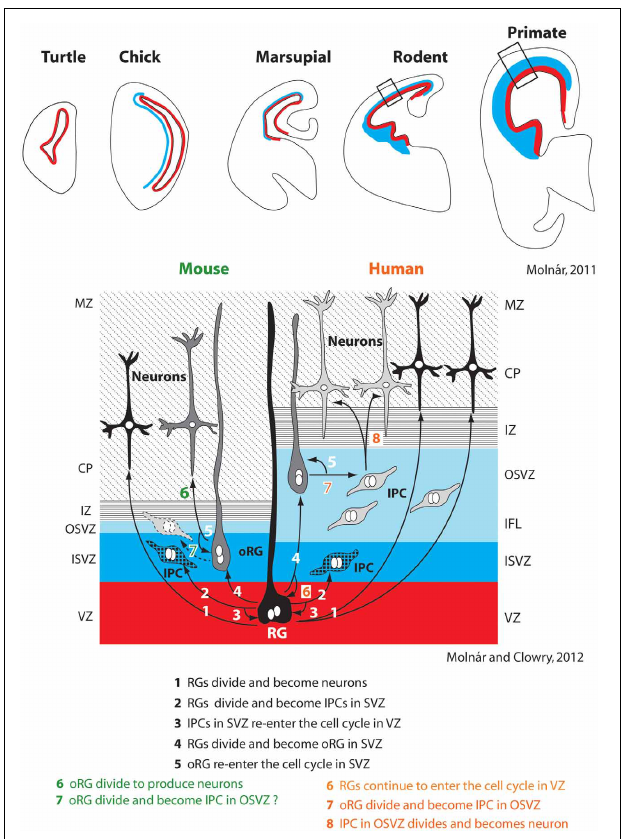
FIGURE 3 | Changes in the subventricular zone (SVZ; blue) in vertebrates (top row). Specific alterations in cell cycle kinetics, the overall thickness of the SVZ, the proportion of the SVZ corresponding to the inner and outer layers (ISVZ and OSVZ respectively), and the proportion of asymmetrical radial glial (RG) and outer radial glial (oRG) cell divisions producing intermediate progenitor cells account for expansion of the neocortex in some lineages, such as primates (right half of bottom panel). The SVZ and particularly the OSVZ is larger in primates than in many other species. While mammals with both a large and small neocortex share a number of aspects of neurogenesis (steps 1–5 bottom figure), several additional adaptations are observed in animals with a large neocortex such as primates. This includes increased thickness of particular layers (such as the OSVZ), additional rounds of division for RGs that re-enter the cell cycle in the ventricular zone (VZ) (6), division of oRGs into intermediate progenitor cells (IPC) in the OSVZ (7), which ultimately divide again to produce neurons (8). Whether oRGs also divide to produce IPCs in rodents is still contentious (dotted line on left side, 7). These figures have been modified from Molnár (2011) and Molnár and Clowry (2012). Abbreviations in Table 1 .